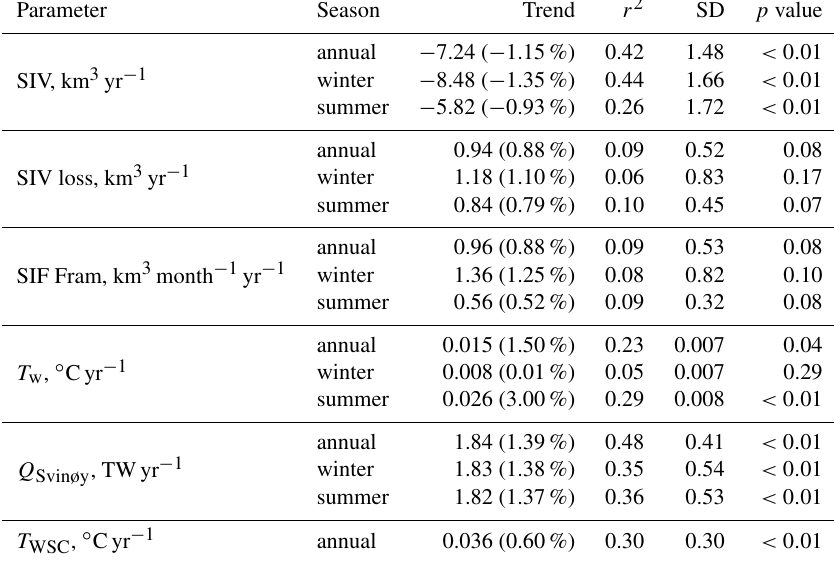
Table 3. Trends in monthly mean characteristics in the Greenland Sea calculated over annual (September–August), winter (October–April) and summer (May–September) periods: sea ice volume (SIV, km 3 yr − 1 ), sea ice volume loss (SIV loss, km 3 yr − 1 ), sea ice flux through Fram Strait (SIF Fram,km 3 year − 1 ), water temperature in MIZ ( T w , ◦ Cyr − 1 ) and in the West Spitsbergen Current (TWSC, ◦ Cyr − 1 ), and heat flux across the Svinøy section ( Q Svinøy , TWyr − 1 ). r 2 is the coefficient of determination, SD is the standard deviation (m) and p value is the probability